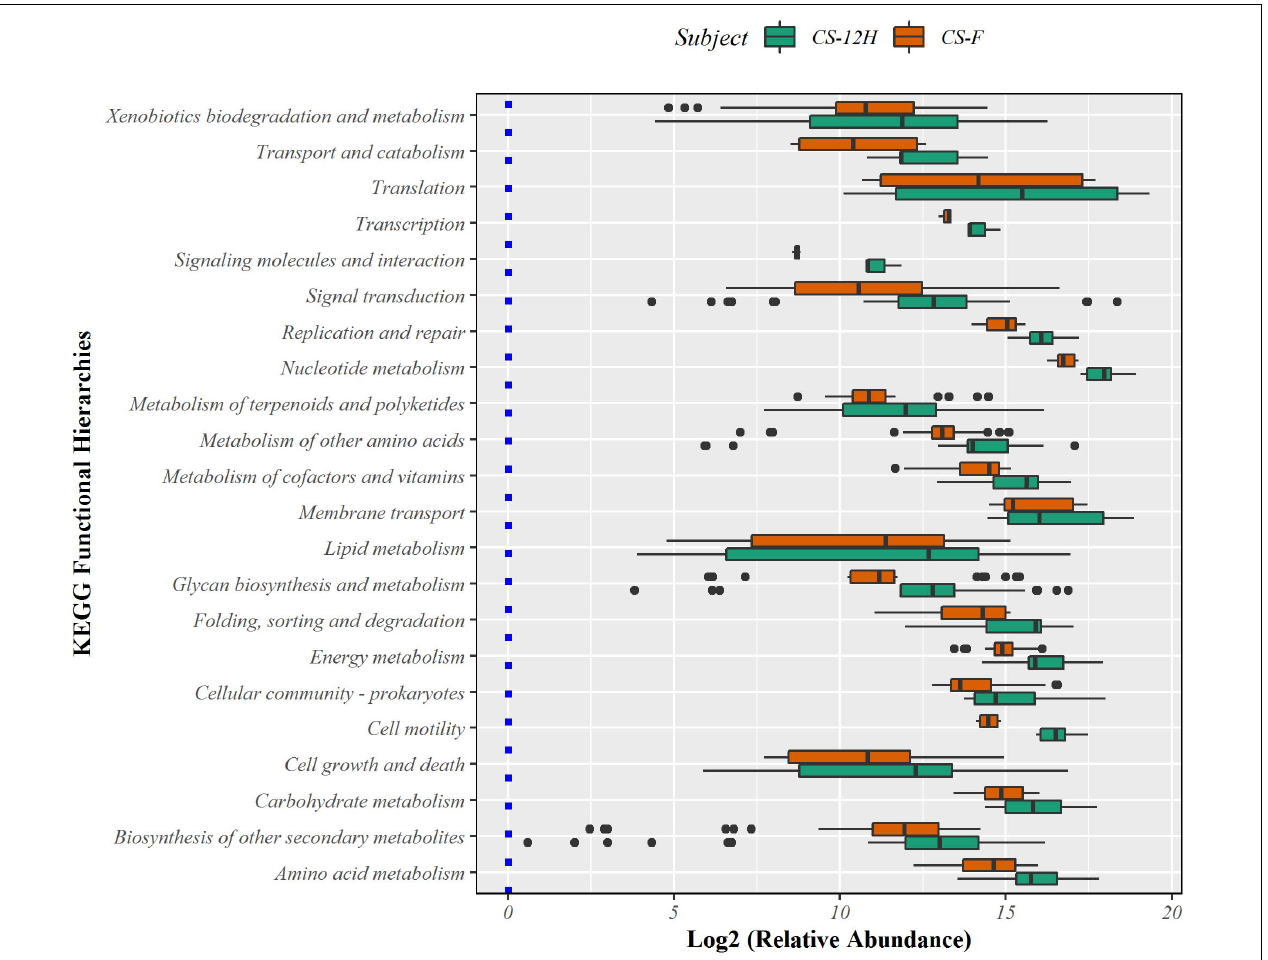
FIGURE 9 | Bar diagram showing abundance box plots for functional hierarchies of KEGG pathway maps present in fresh Kalparasa (CS-F) and 12-h fermented Kalparasa (CS-12H)